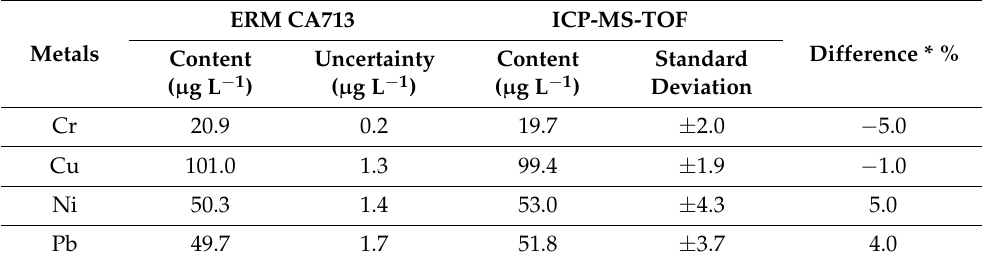
Table 1. The concentration of elements in the certified ERM-CA713 reference material. ERM CA713 Metals